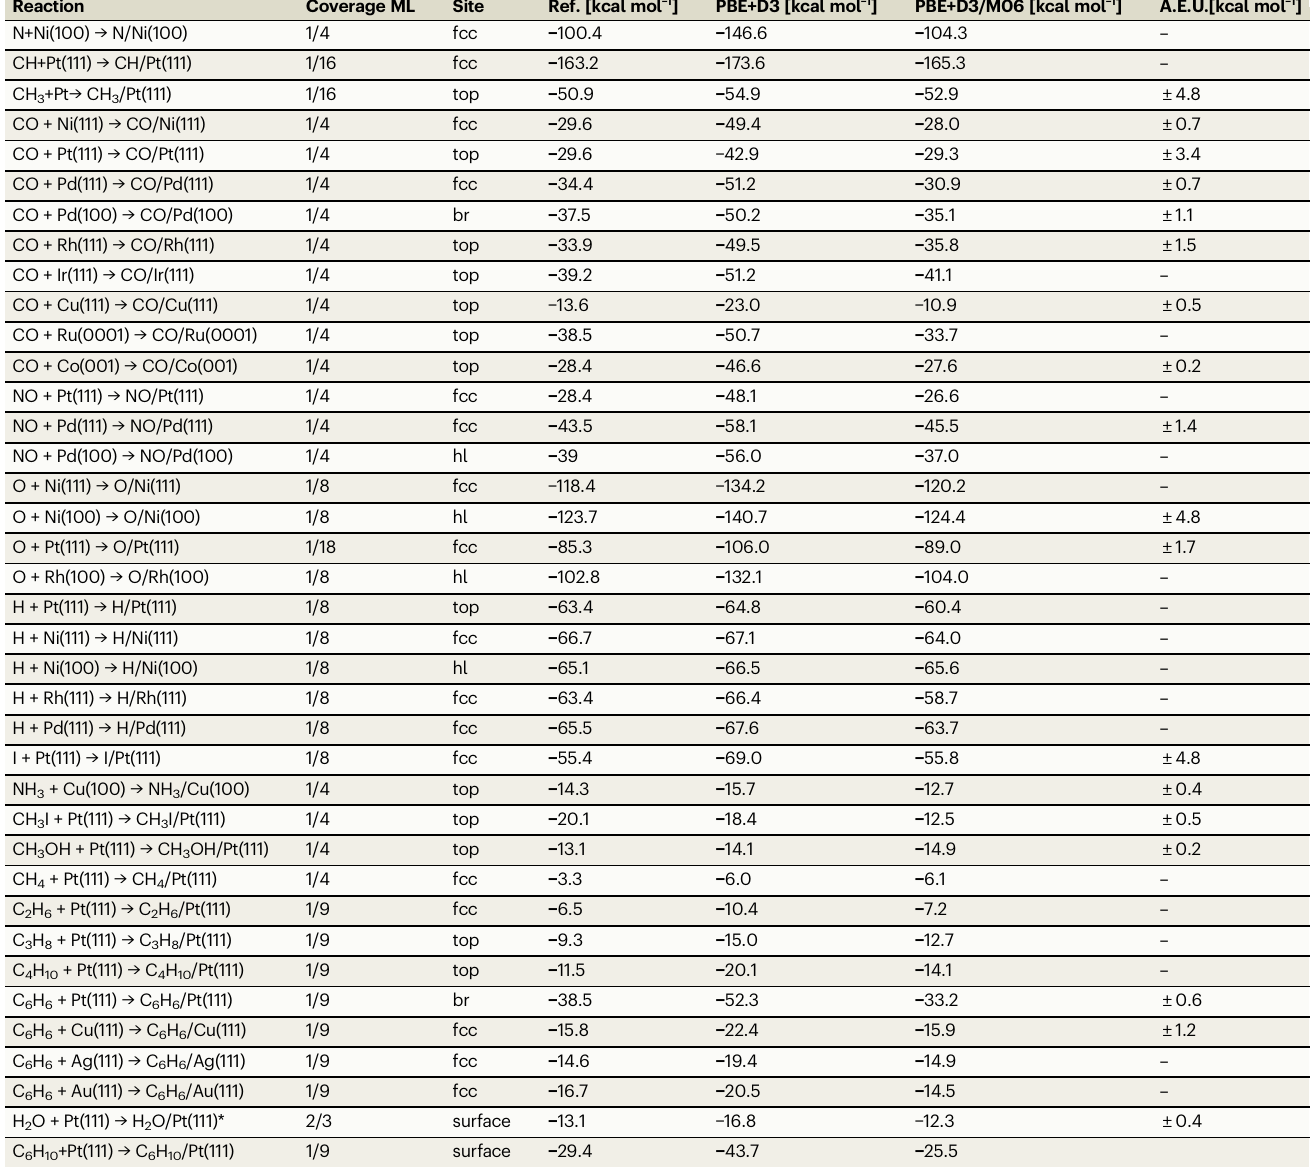
Table 3 | Coverage, adsorption site, reference energies (experimental values with zero-point energies using PBE subtracted), PBE+D3 adsorption energies, the adsorption energies from the PBE+D3/M06 approach and averaged experimental uncer- tainties (A.E.U.) (see Supplementary Note 2; values not found in the literature are marked with dash)